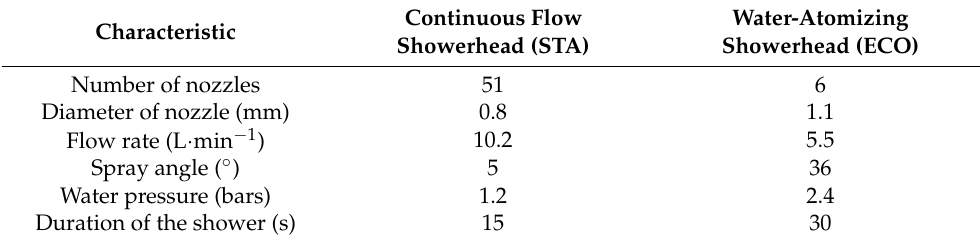
Table 1. Characteristics of the showerheads used in the study. Continuous Flow Characteristic Showerhead (STA)